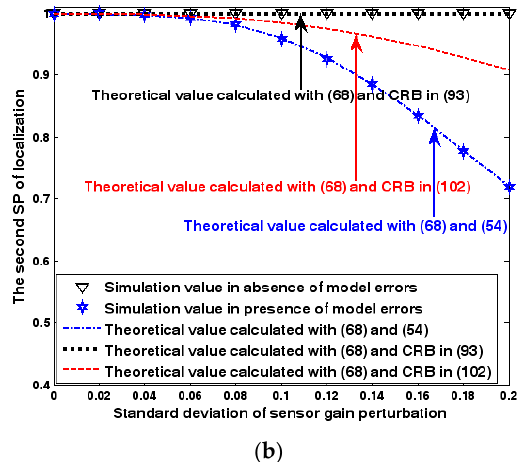
Figure 17. SP of localization as a function of standard deviation of sensor gain perturbation. ( a ) The first SP of localization as a function of standard deviation of sensor gain perturbation. ( b ) The second SP of localization as a function of standard deviation of sensor gain perturbation.